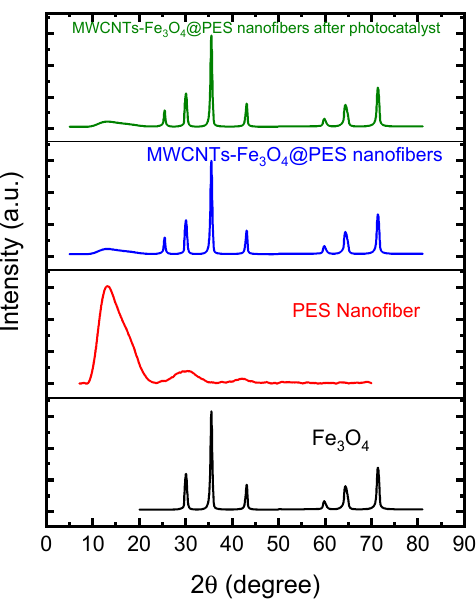
Figure 1. SEM images of ( a ) PES nanofiber, ( b ) PES/MWCNTs-Fe 3 O 4 , ( c ) MWCNTs-Fe 3 O 4 @PES and ( d ) MWCNTs- Fe 3 O 4 @PES composite nanofiber after photodegradation.